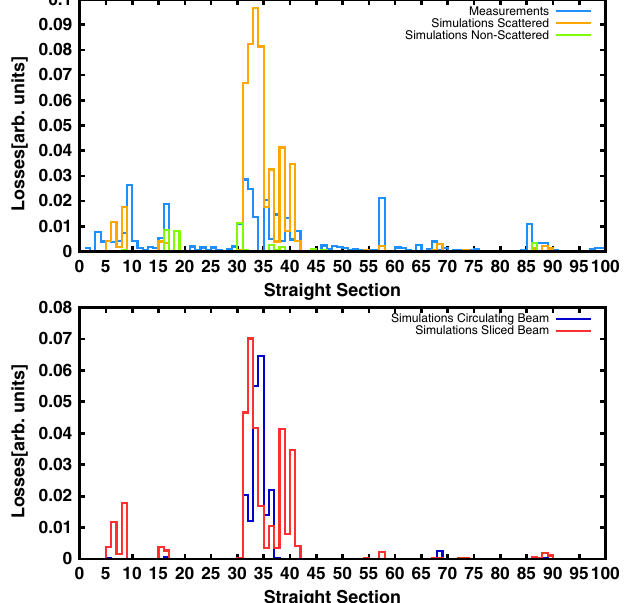
FIG. 15. Beam loss distribution for normal CT operation. Top, BLM measurements (blue) are compared with simulations (green, lost particles nonscattered, and orange, particles scat- tered by the blade). Bottom, simulation results for scattered particles differentiating into sliced particles (red), i.e., outscat- tered into the field region, and circulating particles (blue), i.e., outscattered into the vacuum pipe.